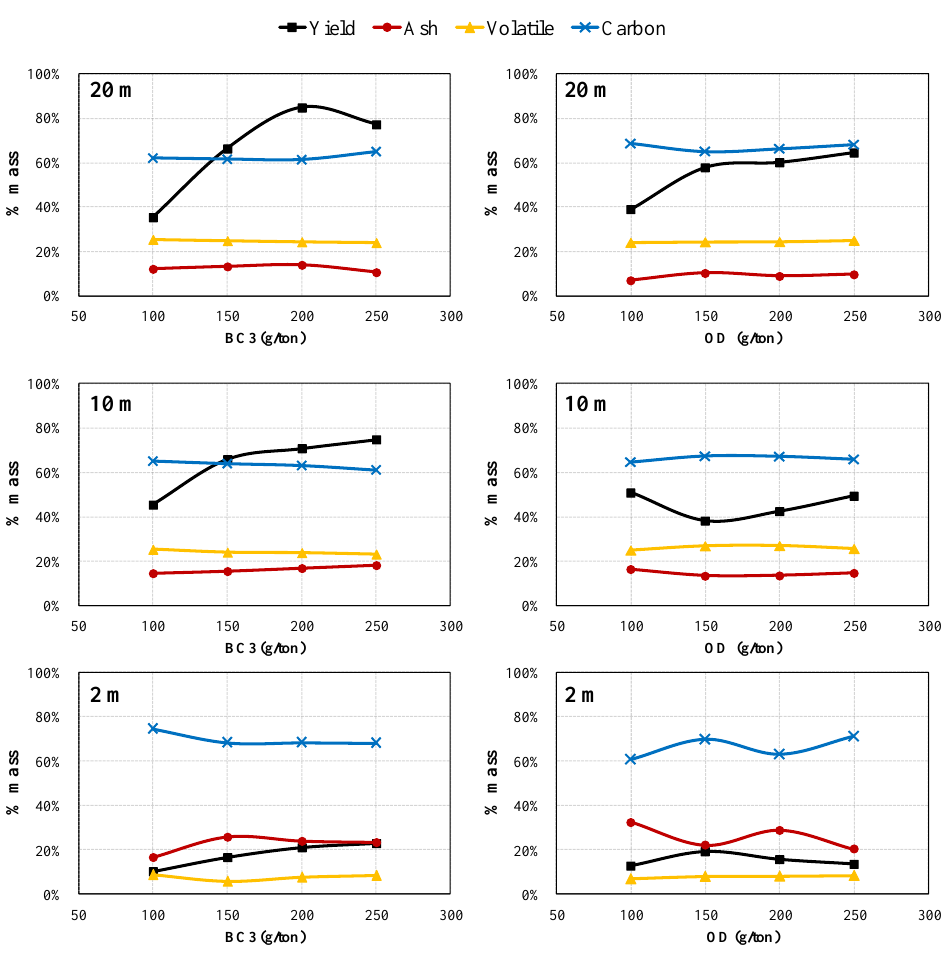
Figure 8. Flotation results (yield and concentrate composition) for the different tested conditions.